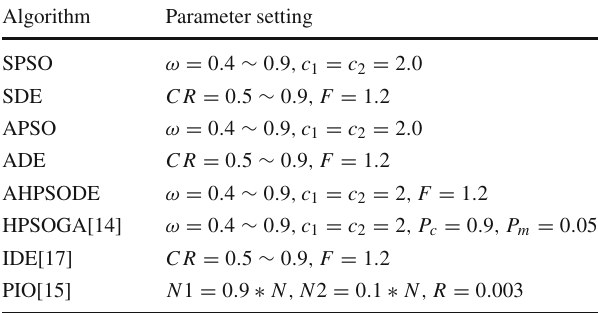
Table 3 Parameter settings for different algorithms